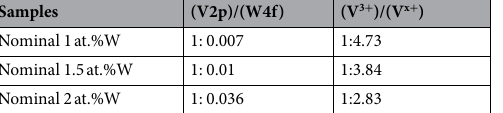
Table 1. Intensity ratios of (V2p)/(W4f) and (V x + )/(V 3 + ) for films annealed at 470 °C according to the XPS survey spectrum.